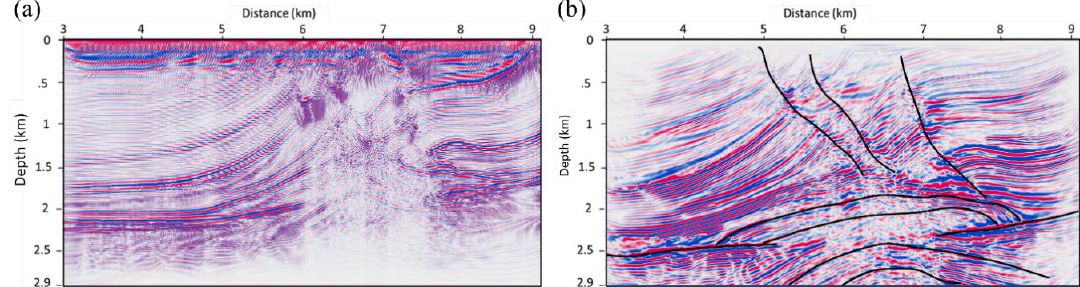
Figure 12. ( a ) Seismic migration using prestack Kirchhoff migration. A velocity model was updated using semblance velocity analysis. Faults and anticlinal structures that were our targets are not imaged. ( b ) Migrated seismic data using Kirchhoff depth migration, with the hybrid travel time calculated by the eikonal equation and paraxial raytracing. Faults and anticline sections in the deeper section are imaged properly.